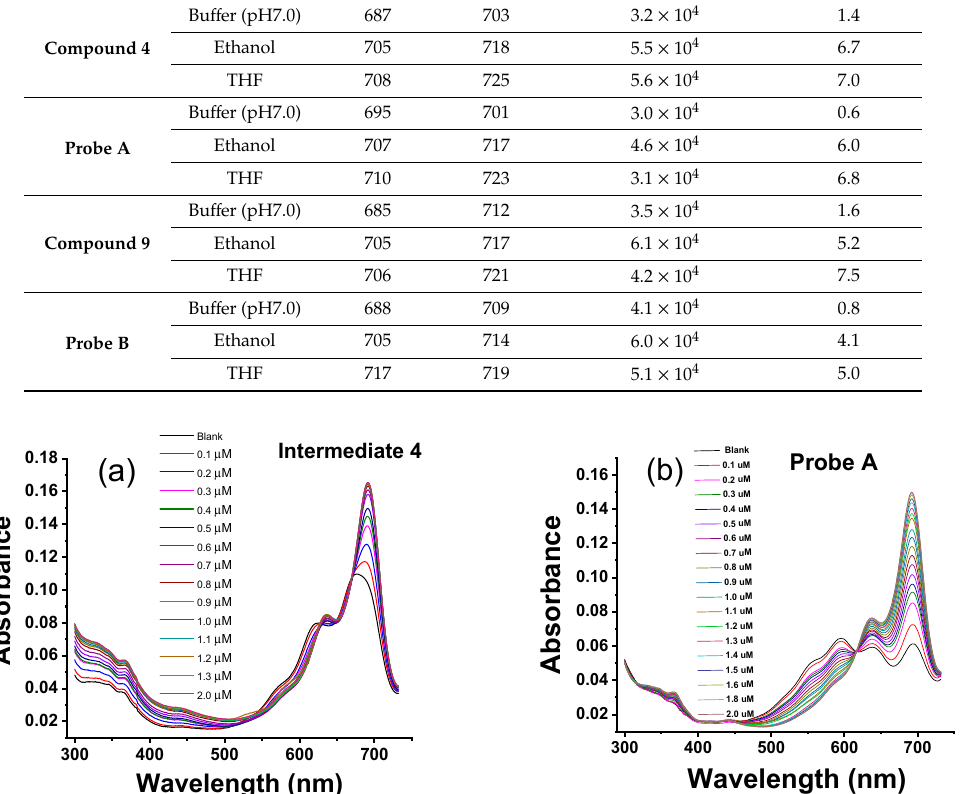
Figure 1. (a) UV-Vis absorption spectra of 1.0 μ M intermediate 4 and (b) UV-Vis absorption spectra of probe A upon gradual addition of Zn(II) from 0.1 μ M to 2.0 μ M to 10 mM HEPES buffer solutions (pH 7.0) containing 1.0 μ M probe A .